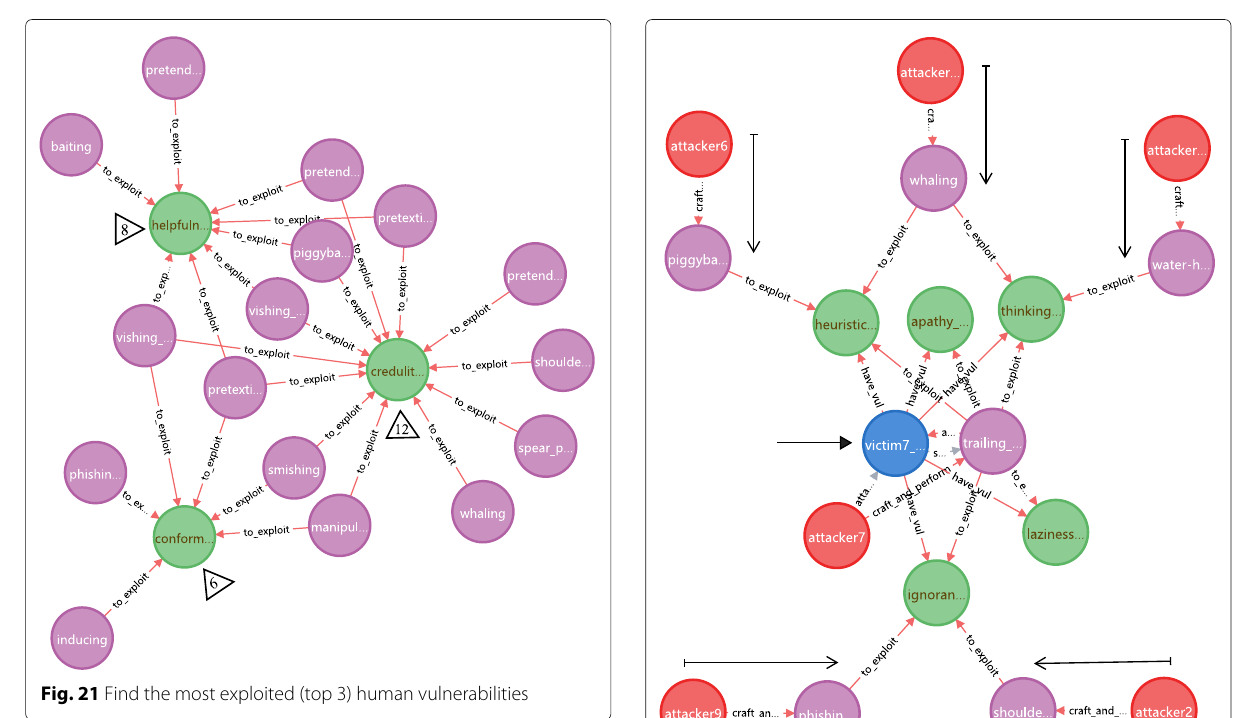
Namely: the attacker a2 can also employ the attack methods am2 to attack victim v1 (i.e. exploited the victim v1’s vulnerabilities hv ), if a victim v1 has certain human vulnerabilities hv and exploited in scenario S1 meanwhile the hv are found also exploited in another scenario S2 by attacker a2 through attack method am2 .